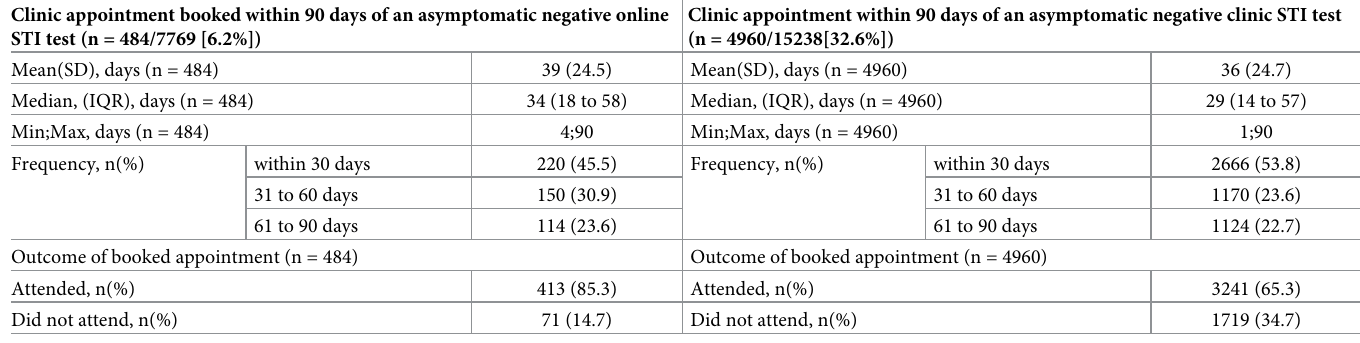
Table 2. Frequency of booking a clinic appointment within 90 days of a negative STI test obtained via online testing or clinic attendance. Clinic appointment booked within 90 days of an asymptomatic negative online STI test (n = 484/7769